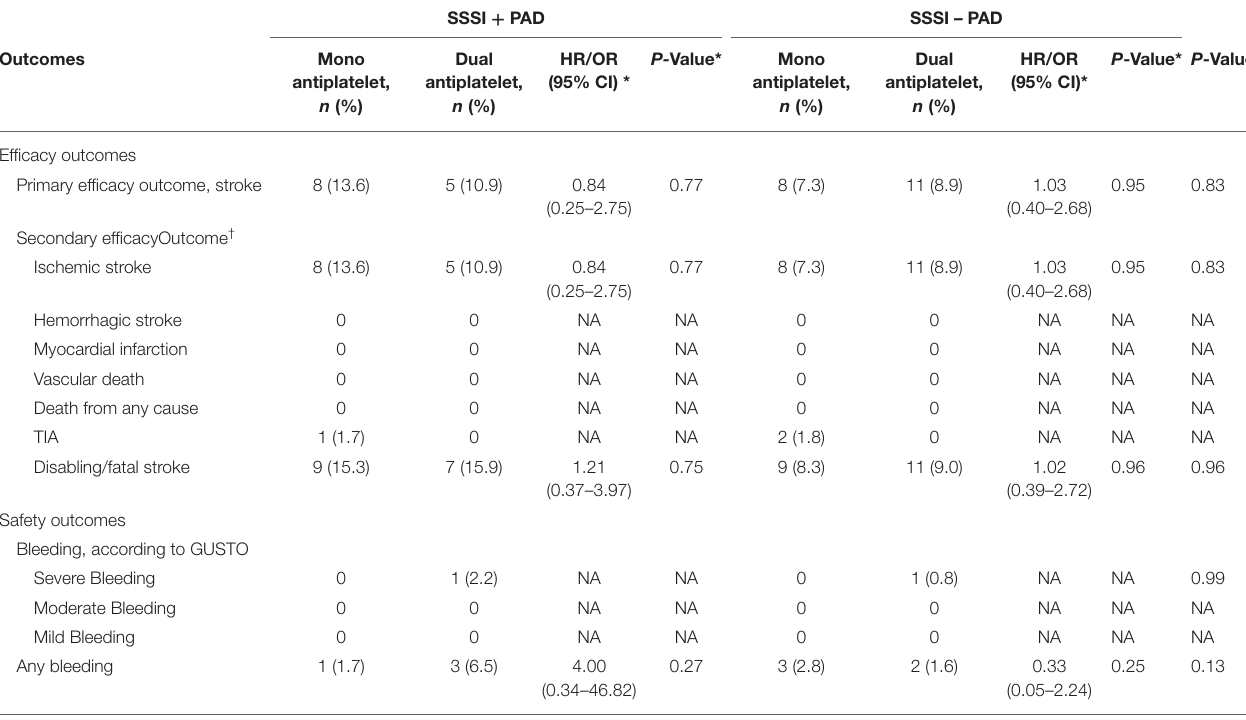
TABLE 2 | Efficacy and safety outcomes of the patients with SSSI + PAD and SSSI – PAD. SSSI + PAD SSSI –